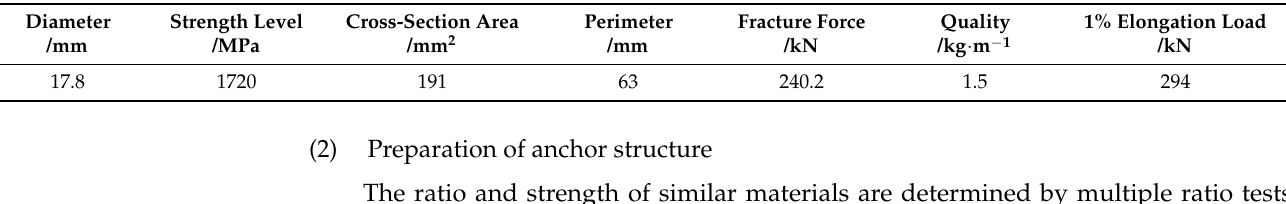
Table 1. Specifications and mechanical property parameters of the bird’s nest anchor